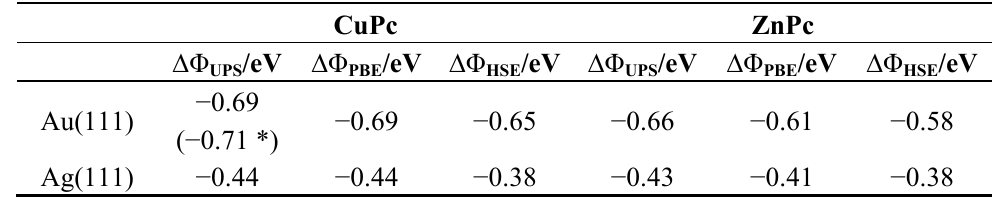
Table 2. Work-function changes induced by the adsorptions of monolayers of CuPc and ZnPc on the Au(111) and Ag(111) surfaces. The experimental data ( ∆Φ measured at room temperature and for CuPc on Au(111) also at 50 K (value designated by *). The calculated values have been obtained using the PBE ( ∆Φ ). The total work functions of the studied interfaces can be obtained from these ( ∆Φ HSE values by adding the metal work-functions § that amount to 5.20 (5.16) eV for Au and 4.48 (4.41) eV for Ag, when calculated with PBE (HSE06).